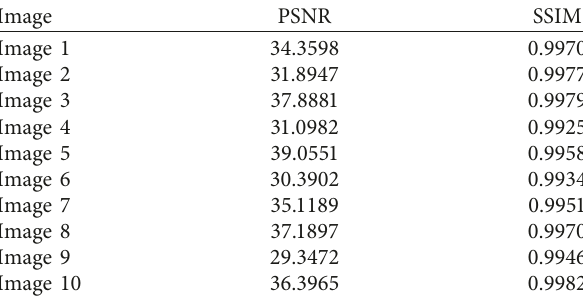
Table 1: PSNR and SSIM for tested